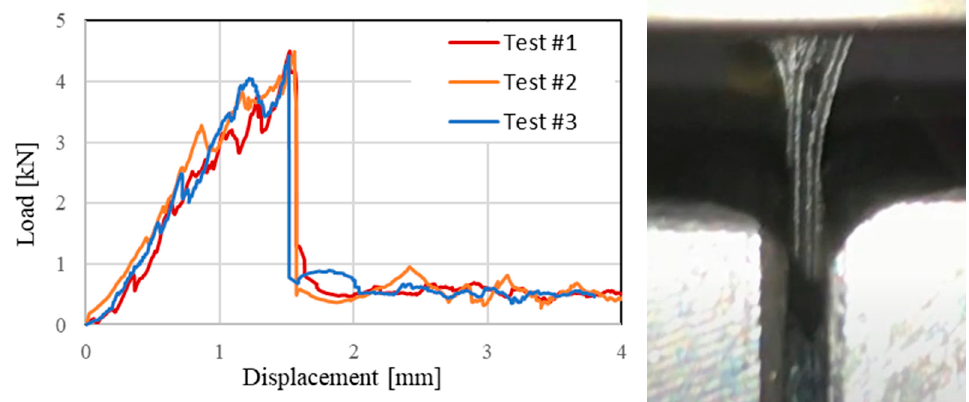
Figure 8. The results of the flat specimens: load-displacement curve ( left ) and deformed shape ( right ).